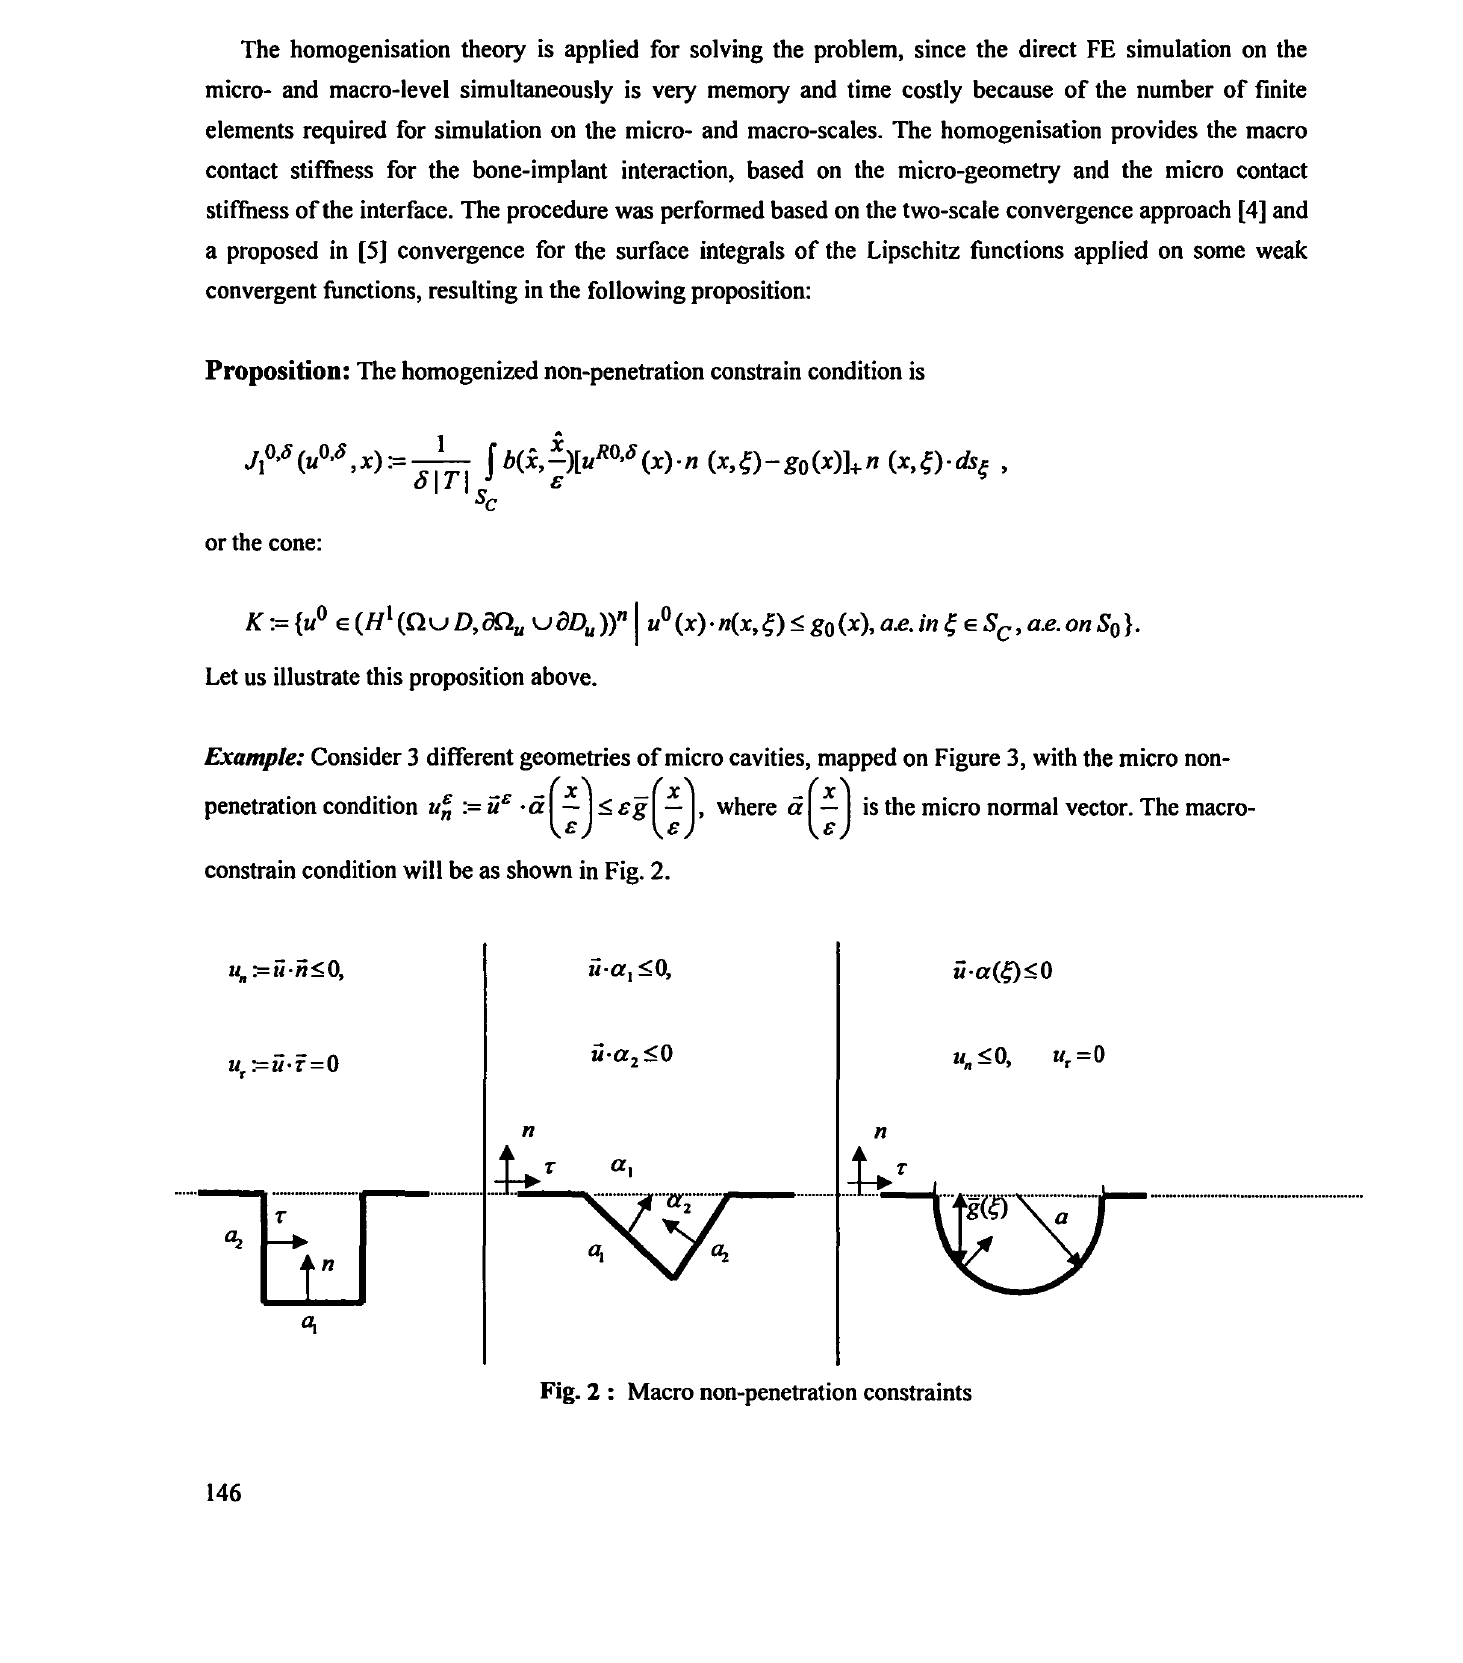
Fig. 2 : Macro non-penetration